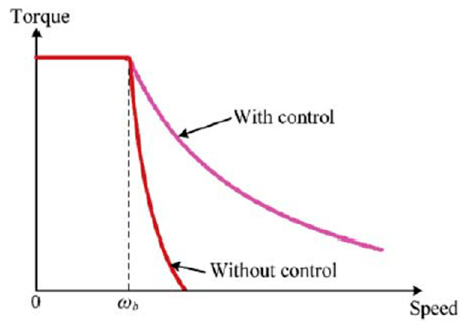
Figure 9. Torque–speed capabilities of phase-advance angle control of PM BLDC motor.